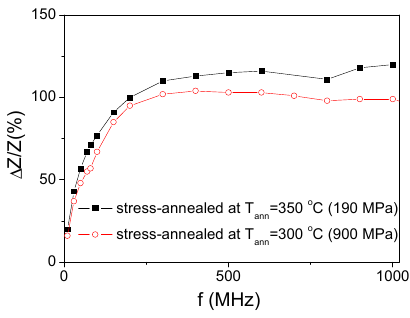
Figure 18. Frequency dependence of maximum GMI ratio for stress-annealed ( T ann = 350 °C, σ a = 190 MPa and T ann =300 °C, σ a = 900 MPa) Fe 75 B 9 Si 12 C 4 microwires.